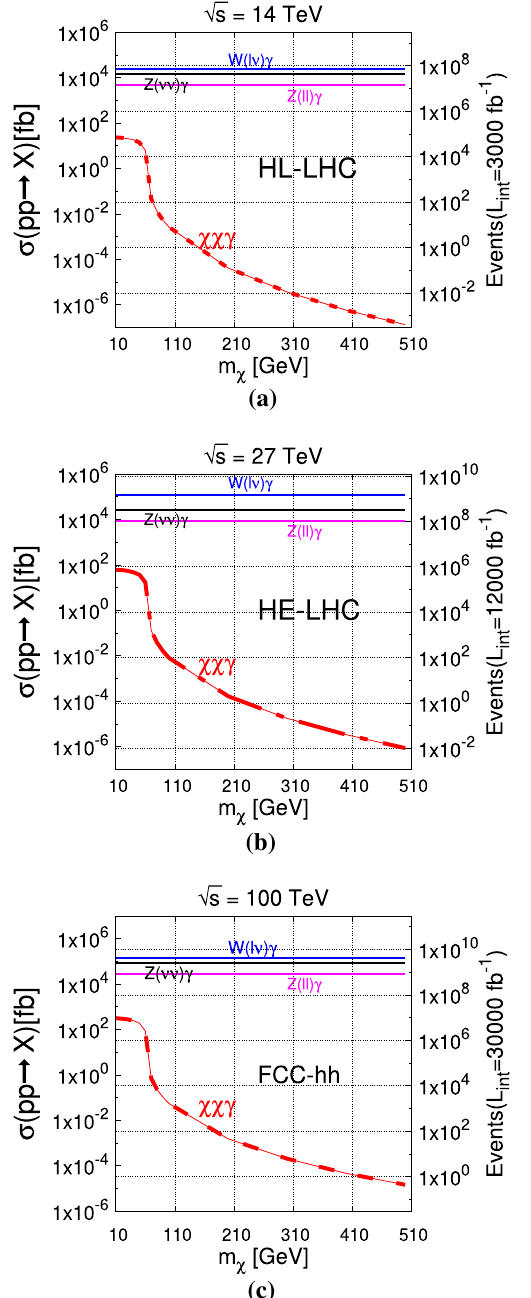
Fig. 9 On the left axis: production cross section for the signal pp → χχγ and SM background processes W ( → (cid:2)ν)γ , Z ( → νν)γ , Z ( → (cid:2)(cid:2))γ . On the right axis: number of events produced. a HL-LHC at √ s = 14TeV and L int = 3ab − 1 , b HE-LHC at = 12ab − 1 , c FCC-hh at L int